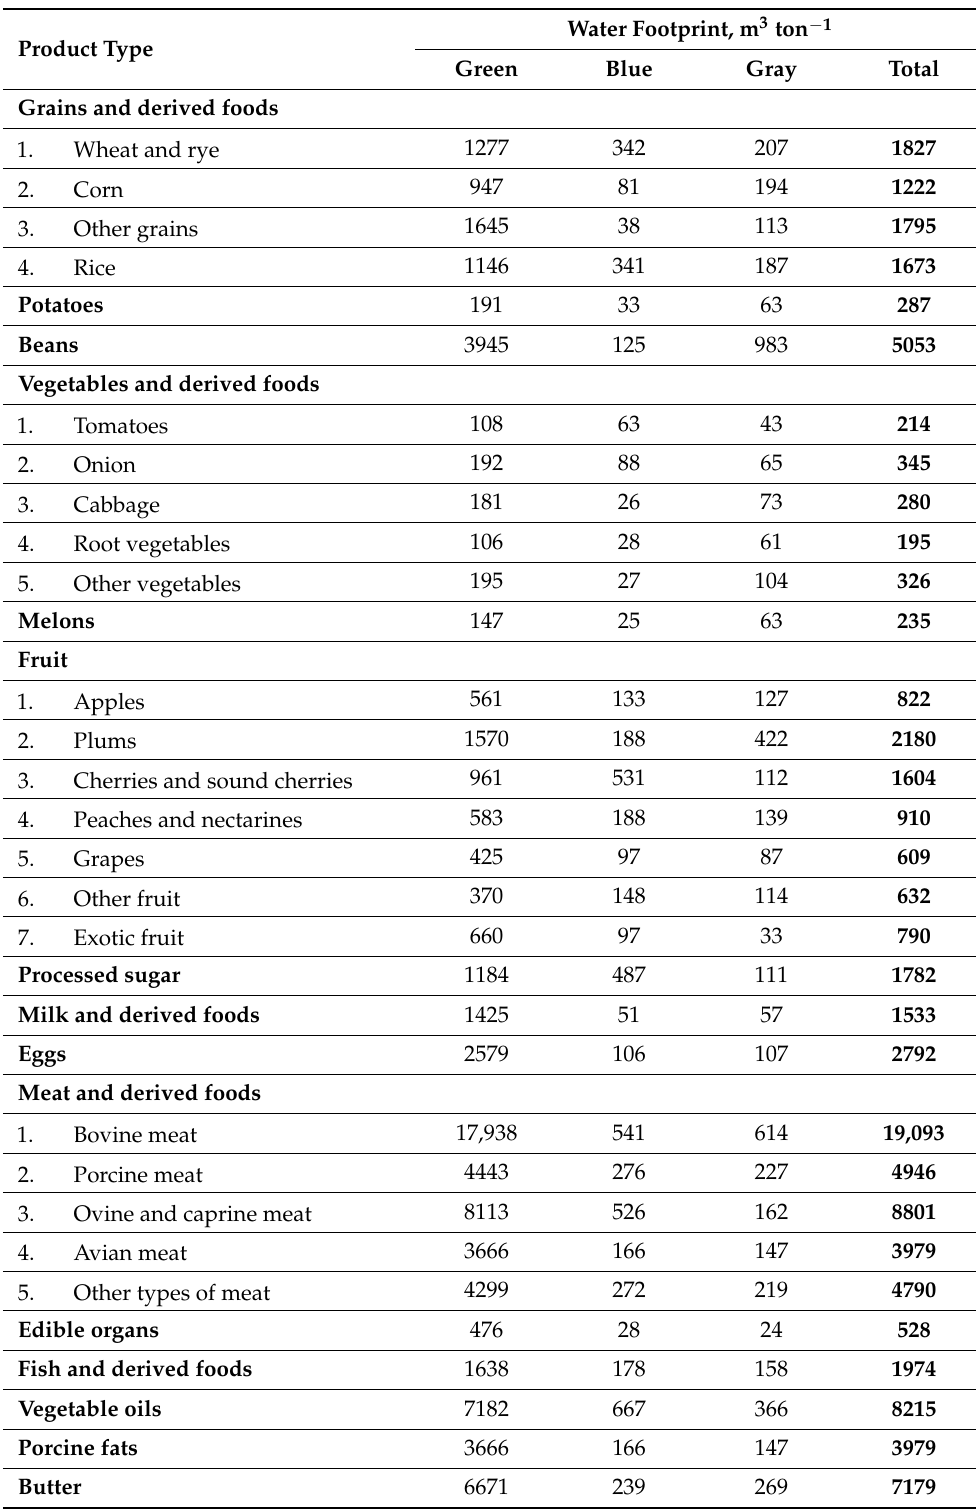
Table 2. Decomposed and total water footprint of food products present in Romania’s food balance for